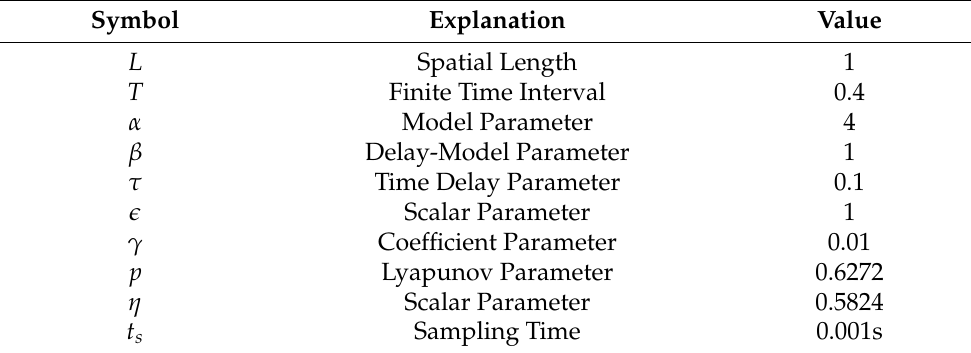
Table 1. Parameter Settings.